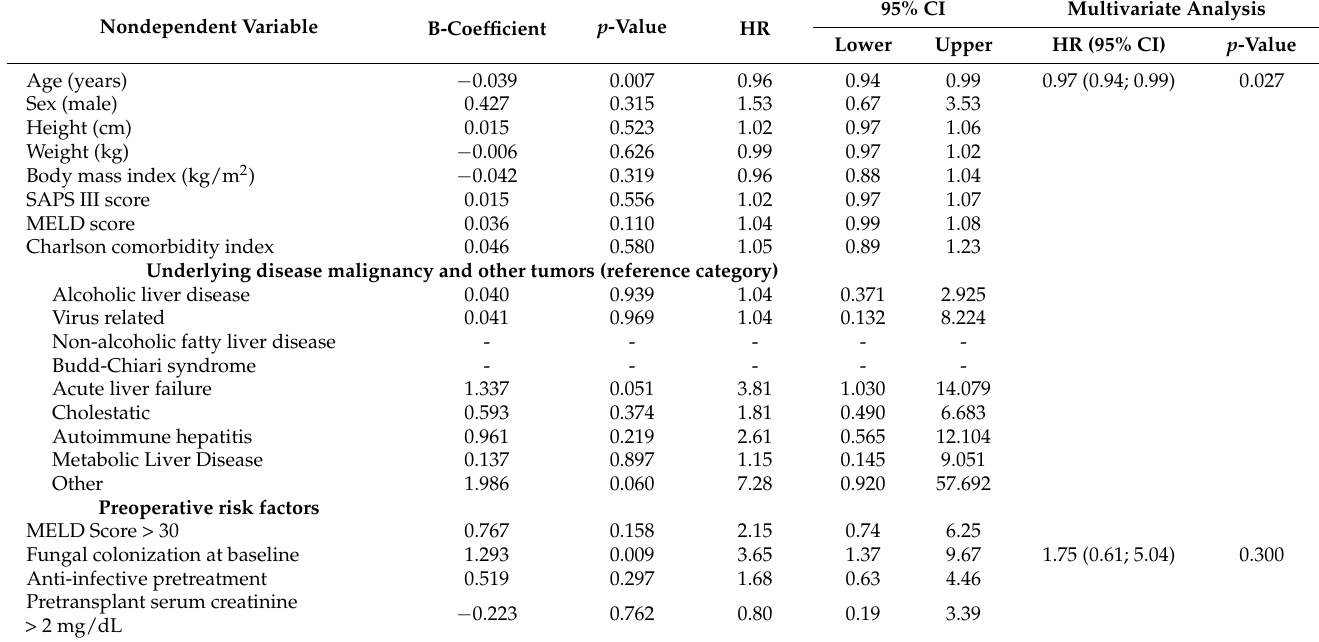
Table 4. Risk factors for IFI within 90 days of liver transplantation: univariate and multivariate Cox regression analyses ( n =